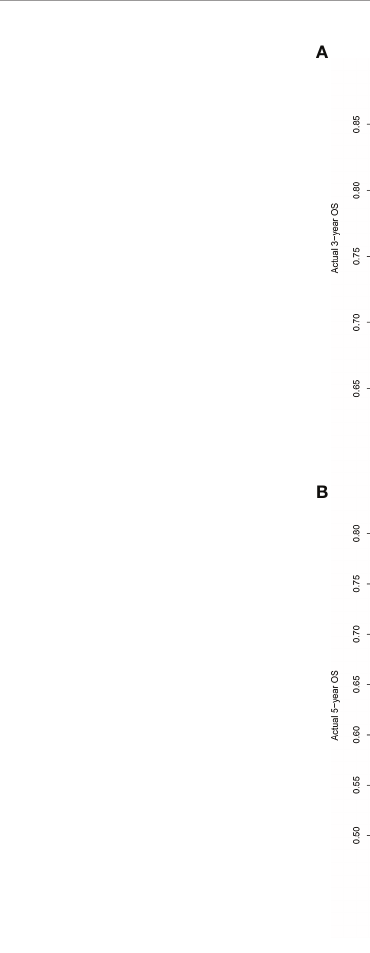
FIGURE 5 | (A) Calibration curve for predicting 3-year OS rates of patients with stage IB NSCLC undergoing surgery. (B) Calibration curve for predicting 5-year OS rates of patients with stage IB NSCLC undergoing